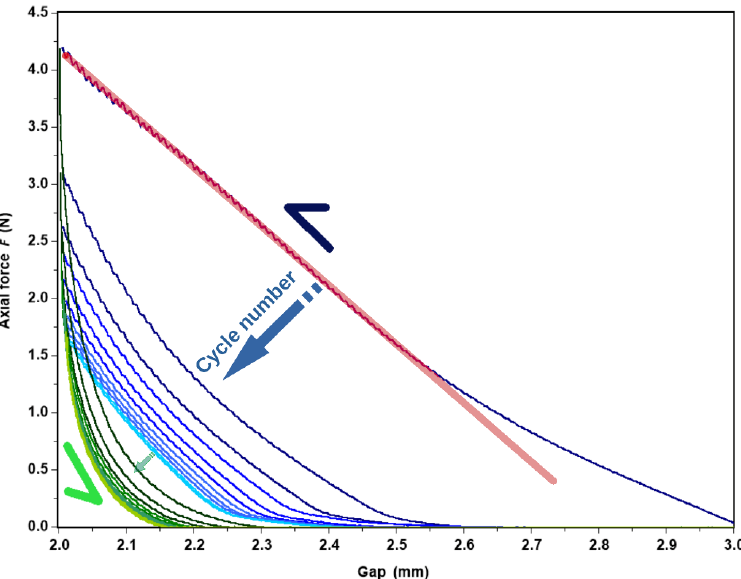
Figure 15. Axial force as a function of gap under a fatigue stress condition, successive compression (blue curves)/traction (green curves) for APP-E gel formed at 10 g L −1 and dialyzed against 1 mol L −1 CaCl 2 . The half arrows indicate the directions of the cycles and the full arrows the evolution of the axial force as a function of the gap as a new compression/traction cycle is applied. The red line corresponds to the best fit obtained on the compression curve at low gap values, thus, allowing us to extract the Young modulus E (see text).